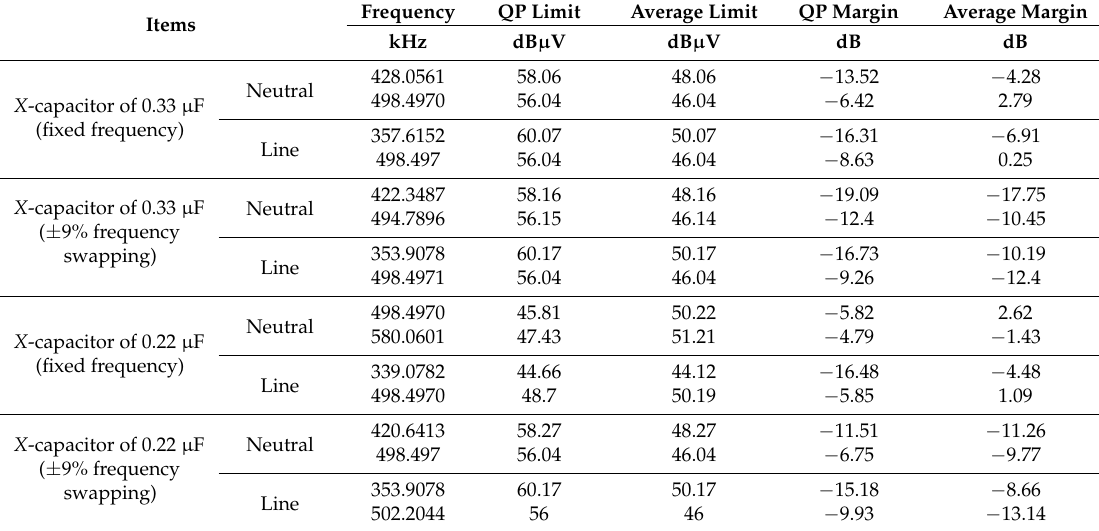
Table 4. Comparison of conducted EMI measurements. QP: